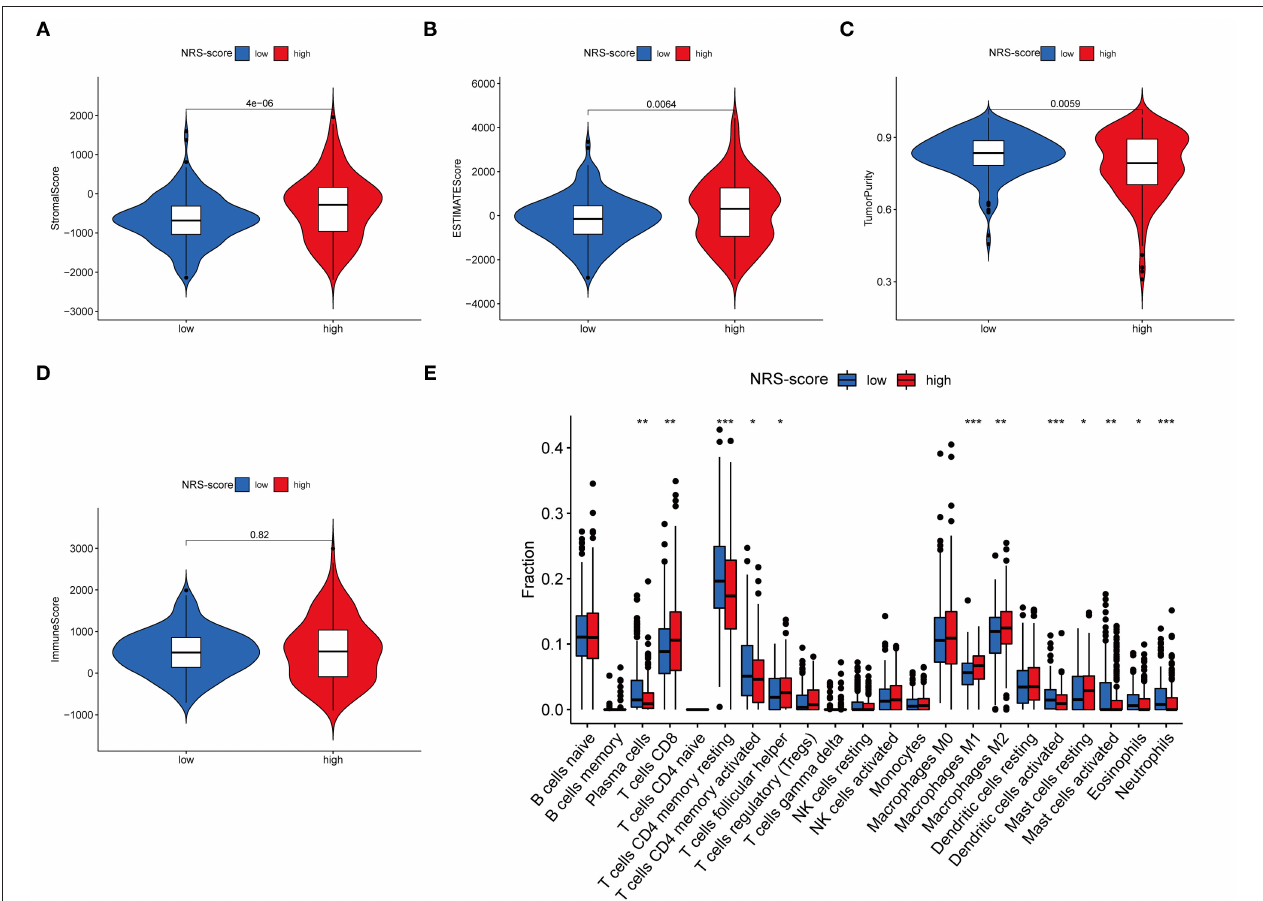
FIGURE 8 | Immune microenvironment infiltration characterization of the prognostic signature. (A) Stromal score between high NRS-score and low NRS-score groups. (B) ESTIMATE score between high NRS-score and low NRS-score groups. (C) Tumor purity between high NRS-score and low NRS-score groups. (D) Immune score between the high NRS-score and low NRS-score groups. (E) Differences in the abundance of 22 immune cells infiltrating CC tumor samples in the low NRS-score and high NRS-score group (* P < 0.05, ** P < 0.01, and *** P < 0.001).